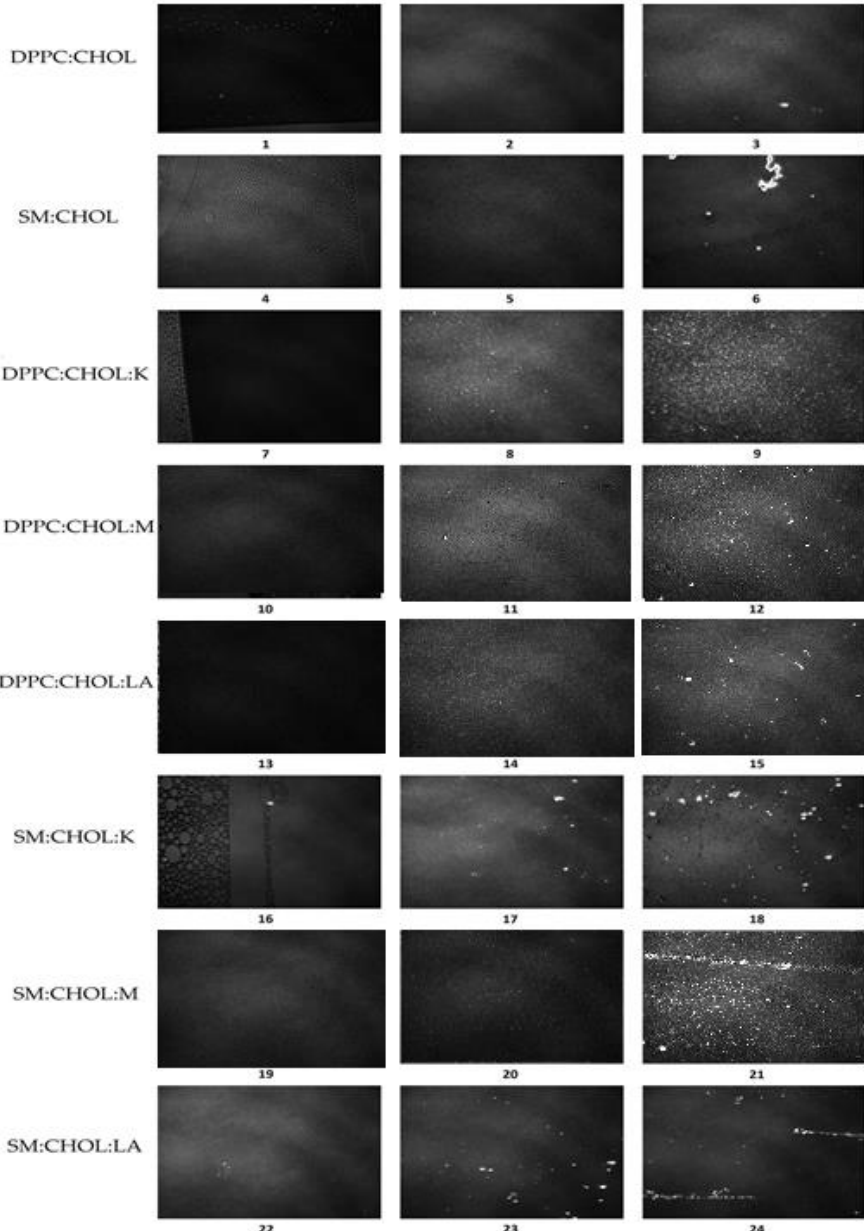
Figure 5. BAM images taken at a temperature of 22 °C at the following surface pressures: (1) 0.1 mN/m, (2) 29.9 mN/m, (3) 42.8 mN/m, (4) 0.1 mN/m, (5) 27.2 mN/m, (6) 40.1 mN/m, (7) 0.1 mN/m, (8) 25.5 mN/m, (9) 42.2 mN/m, (10) 0.1 mN/m, (11) 23.4 mN/m, (12) 41.2 mN/m, (13) 0.1 mN/m, (14) 23.8 mN/m, (15) 43.5 mN/m, (16) 0.1 mN/m, (17) 22.8 mN/m, (18) 44.1 mN/m, (19) 0.1 mN/m, (20) 22.4 mN/m, (21) 44.9 mN/m, (22) 0.1 mN/m, (23) 22.7 mN/m, (24) 43.9 mN/m. The observation of the occurring phase changes confirmed the existence of the fol- lowing phases: gas (G), extended liquid (LE), and condensed (LC), with the possibility of